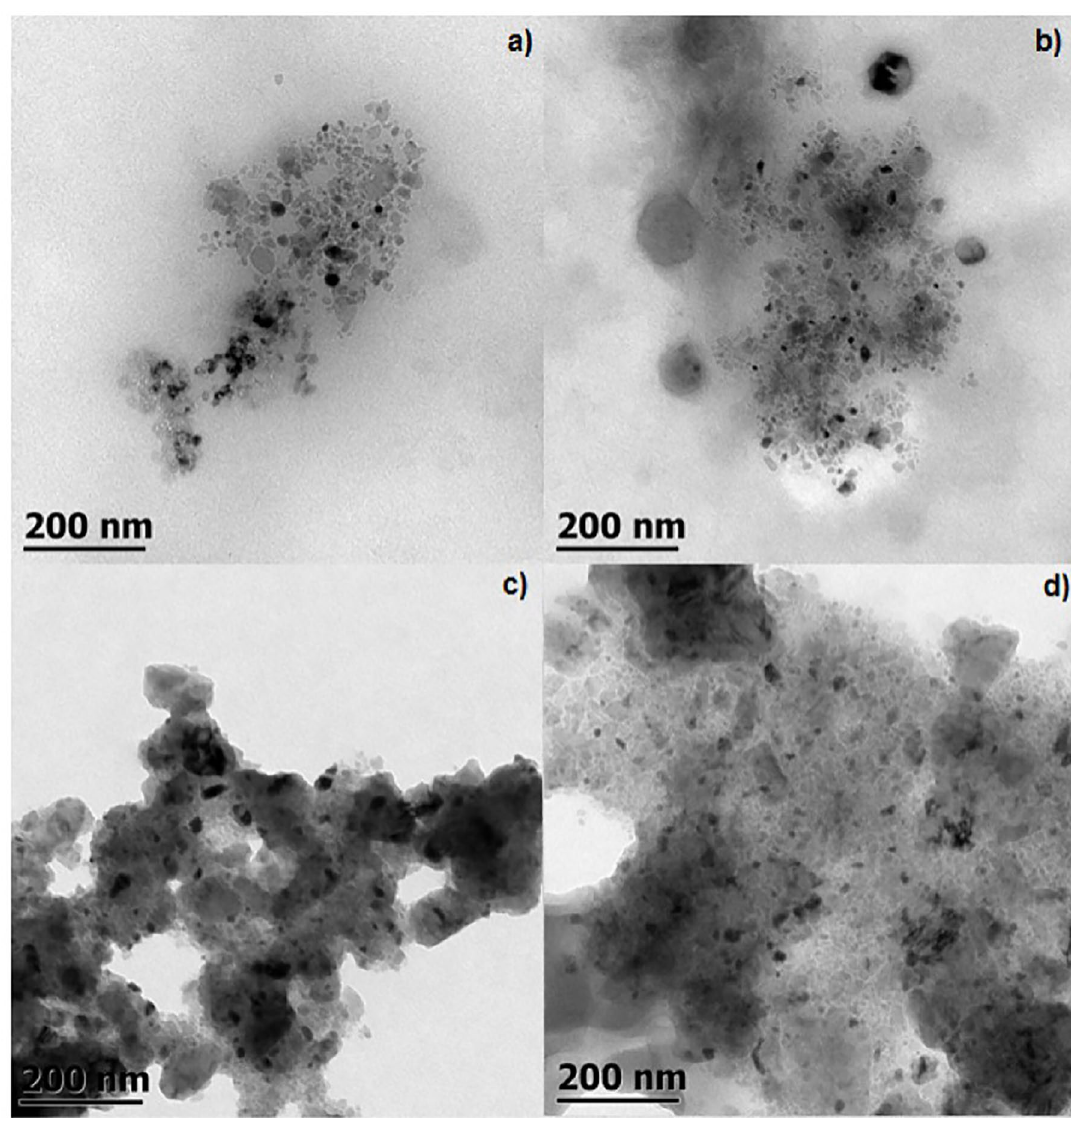
U t= 1 h, b) C-M 10 50